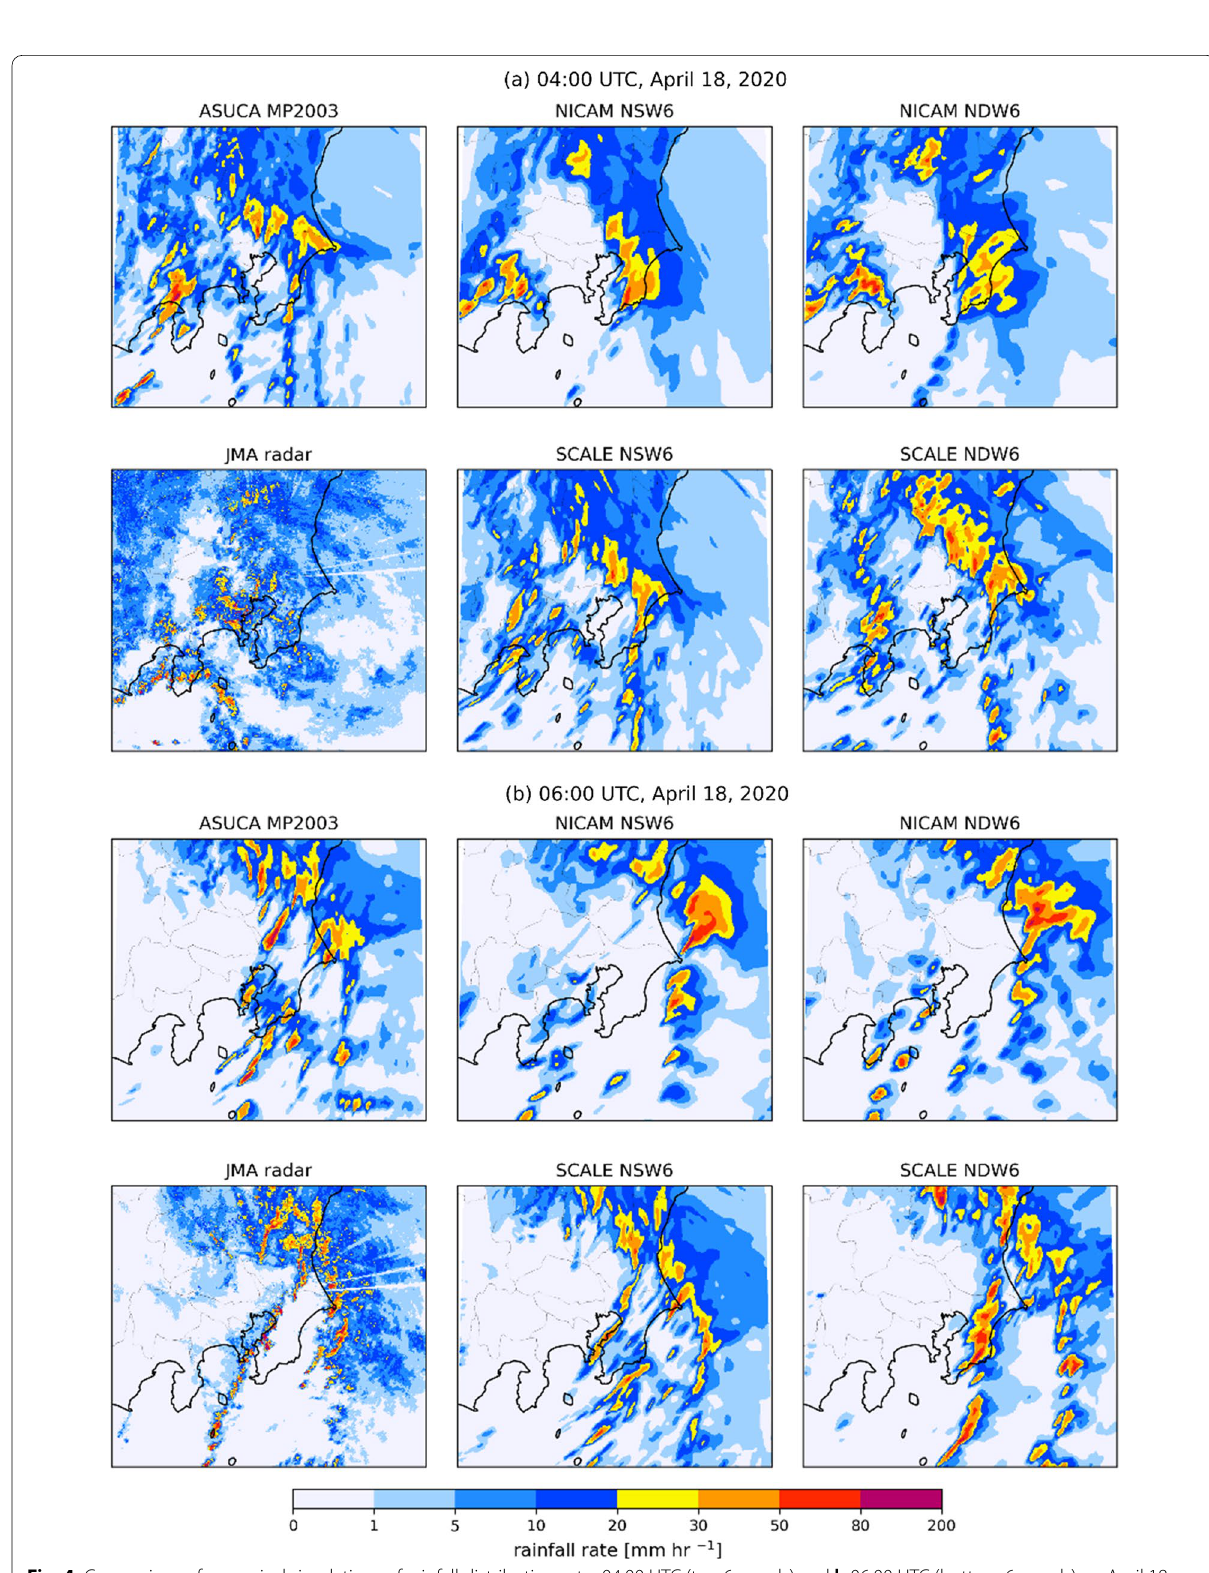
Fig. 4 Comparison of numerical simulations of rainfall distributions at a 04:00 UTC (top 6 panels) and b 06:00 UTC (bottom 6 panels) on April 18, 2020. In each group of 6 panels; Top row, from left to right: ASUCA 1-km grid, NICAM-NSW6 1.4-km grid, NICAM-NDW6 1.4 km grid; Bottom row, from left to right: radar observation rainfall rate, SCALE-NSW6 1 km grid, and SCALE-NDW6 1 km